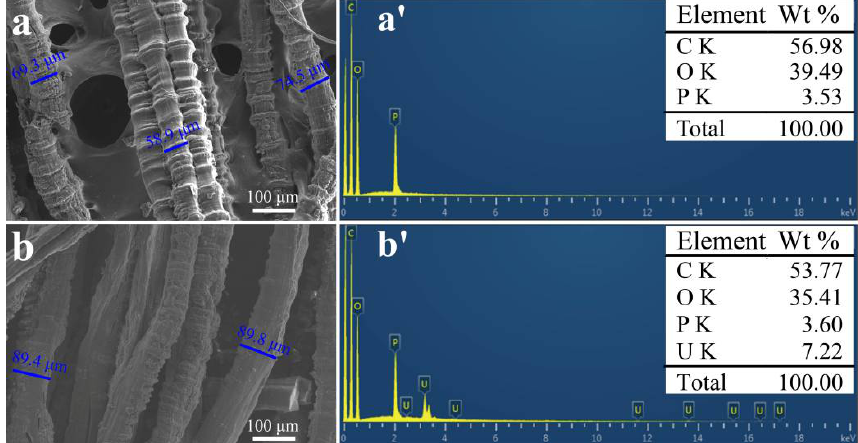
Figure 4. SEM pictures, EDX spectra of UHMWPE-g-PO 4 fibers (DG = 630%; D PO = 2.01 mmol∙g −1 ) before ( a , a' ) and after ( b , b' ) U(VI) adsorption (C 0 : 20.0 mg∙L −1 , sorbent: 0.2 g, volume: 1 L, NaF: 2.0 g∙L −1 , time: 24 h, and temperature: 25 °C).